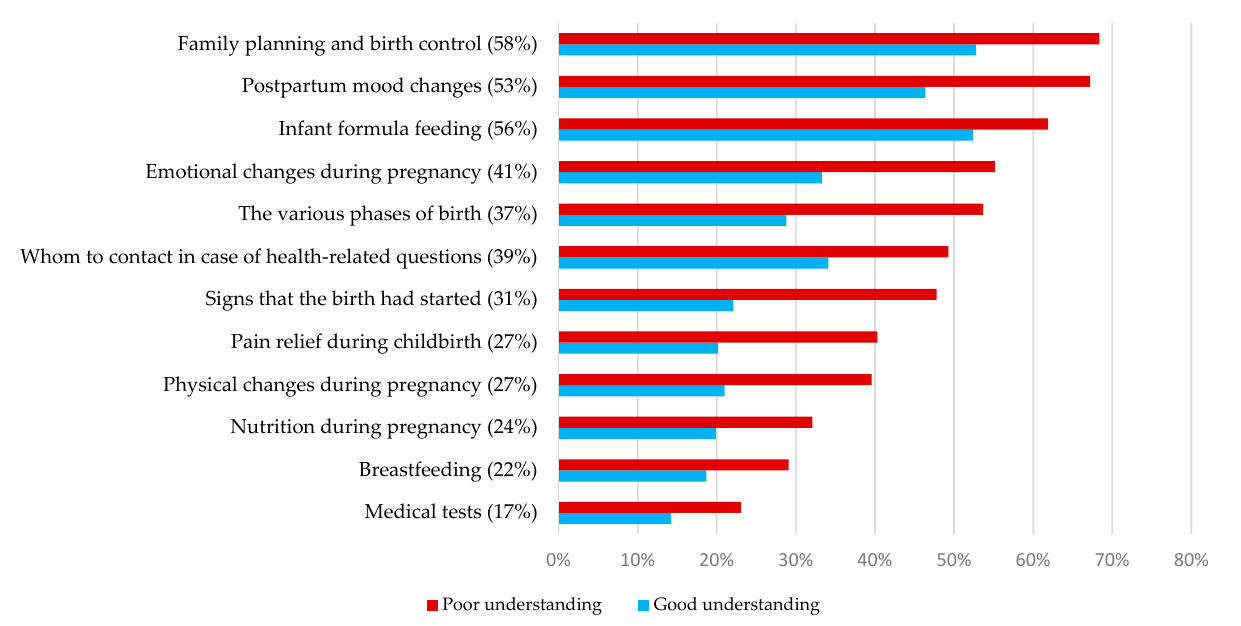
Figure 1. Proportion of women who reported receiving insufficient coverage of various maternal health topics (percentage of all) and by poor and good understanding of information provided by maternity staff.